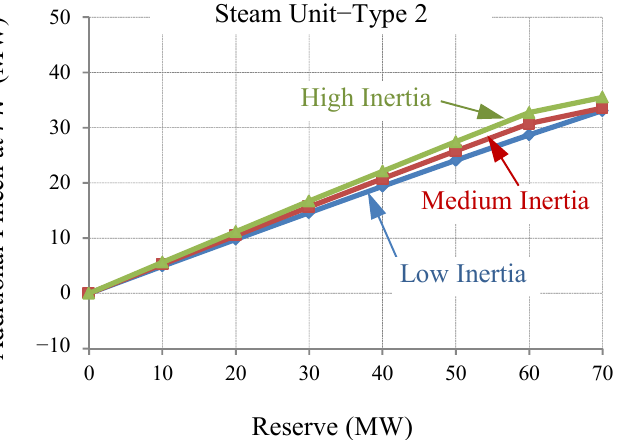
Figure 5. Additional mechanical power of Steam Unit—Type 2 as response for 350 MW trip, in 3 inertia conditions.